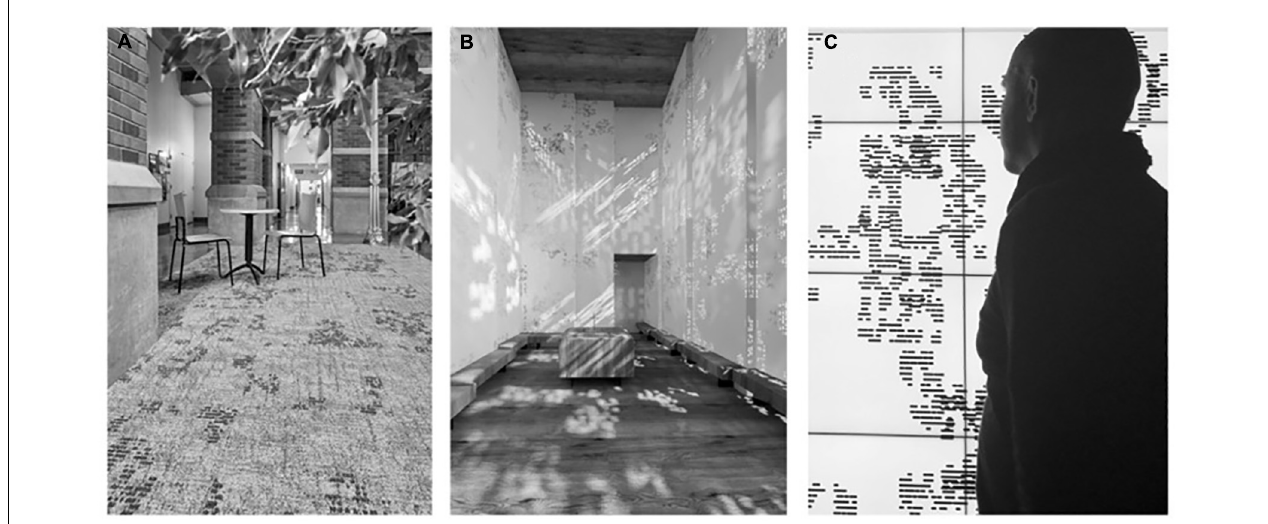
FIGURE 4 | Installations. The fractal pattern of Figure 3 employed as a floor design at the University of Oregon, United States (A) , as wall patterns in the Fractal Chapel in the State Hospital in Graz, Austria (B) , and as a design for computer screen-savers (C)